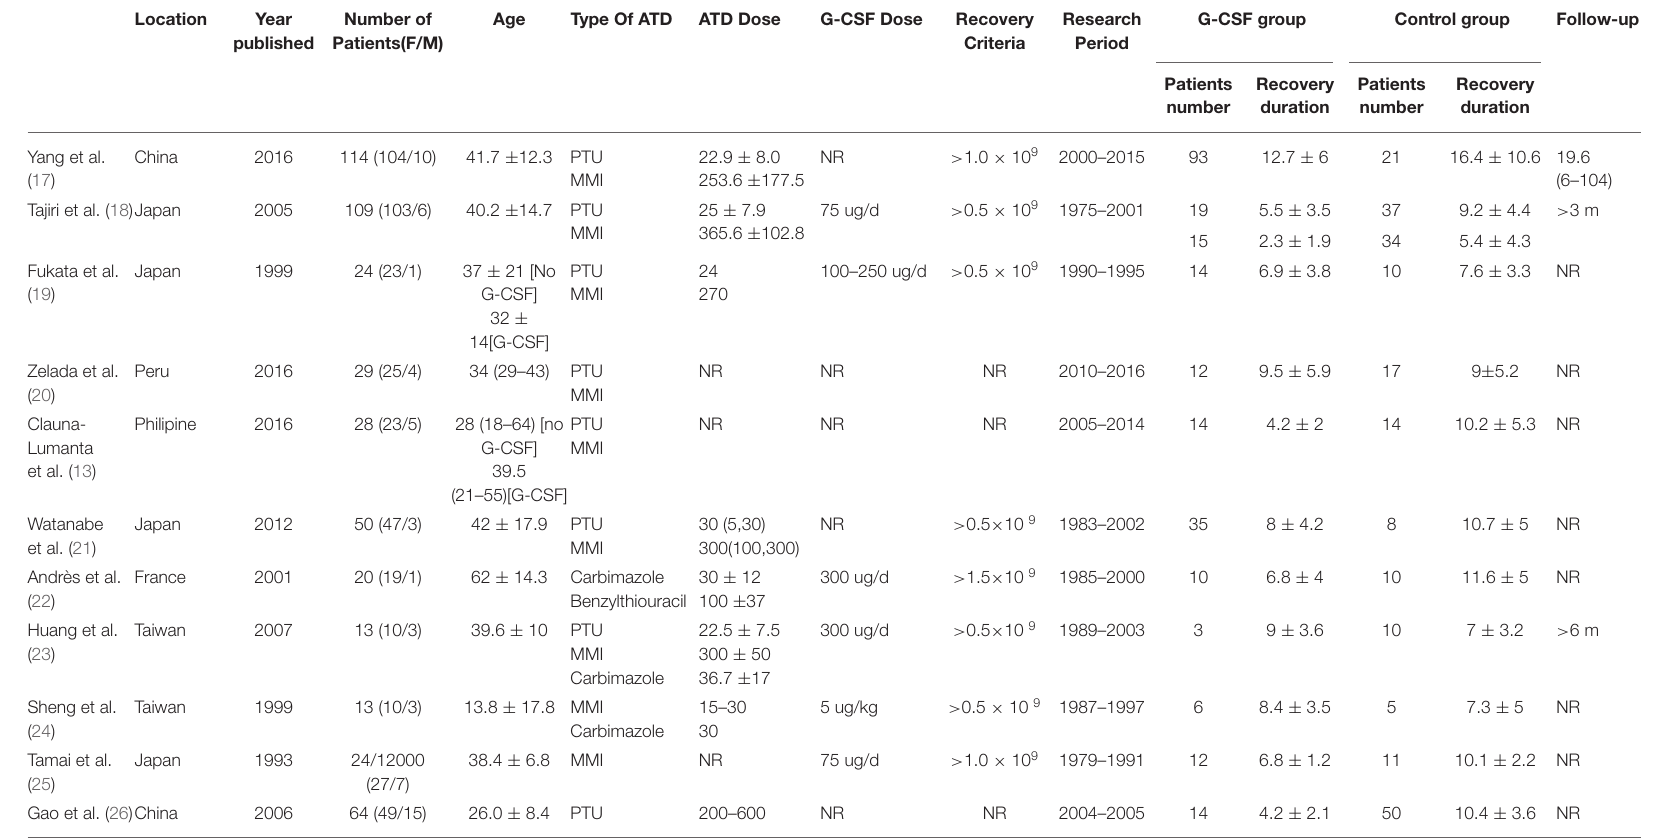
TABLE 1 | Characteristics of the included studies. Location Year